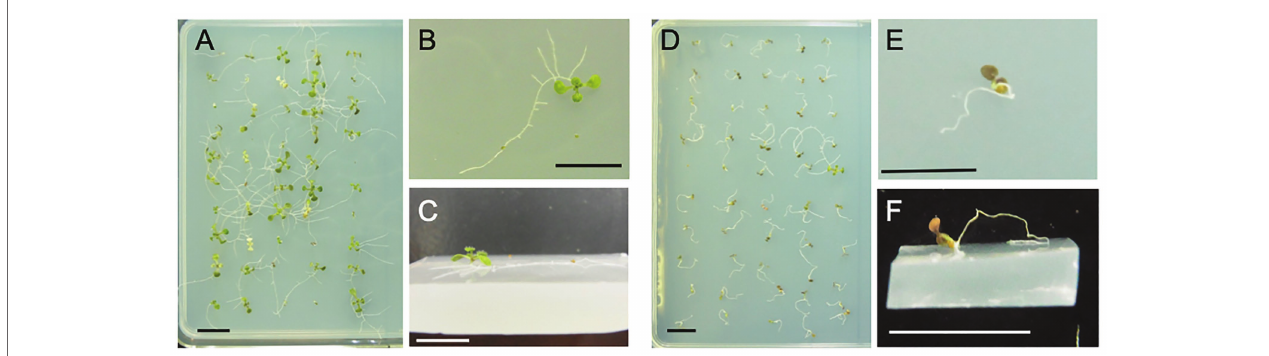
FIGURE 1 | Phenotypes of two control lines used for screening in the present study. (A–C) The axr4 mutant line and (D–F) the wild type (Col-0) line. Both lines were grown for 15 days on the surface of horizontal 5% gelrite-1/2 Murashige and Skoog (MS) medium. The primary and lateral roots of the axr4 mutant crept over the surface of the medium and remained viable, while the primary root of the wild type sprang up on the surface, leading the seedling to die. The cotyledon and true leaves of the axr4 mutant were green, while those of the wild type were brown, suggesting that the wild type underwent necrosis. (A,D) Above view; (B,E) close-up view from above; and (C,F) oblique close-up view. Scale bar = 1